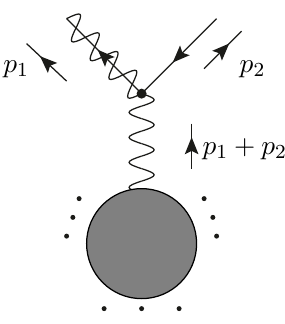
Figure 17 . Feynman diagrams leading to collinear gravitino and gaugino